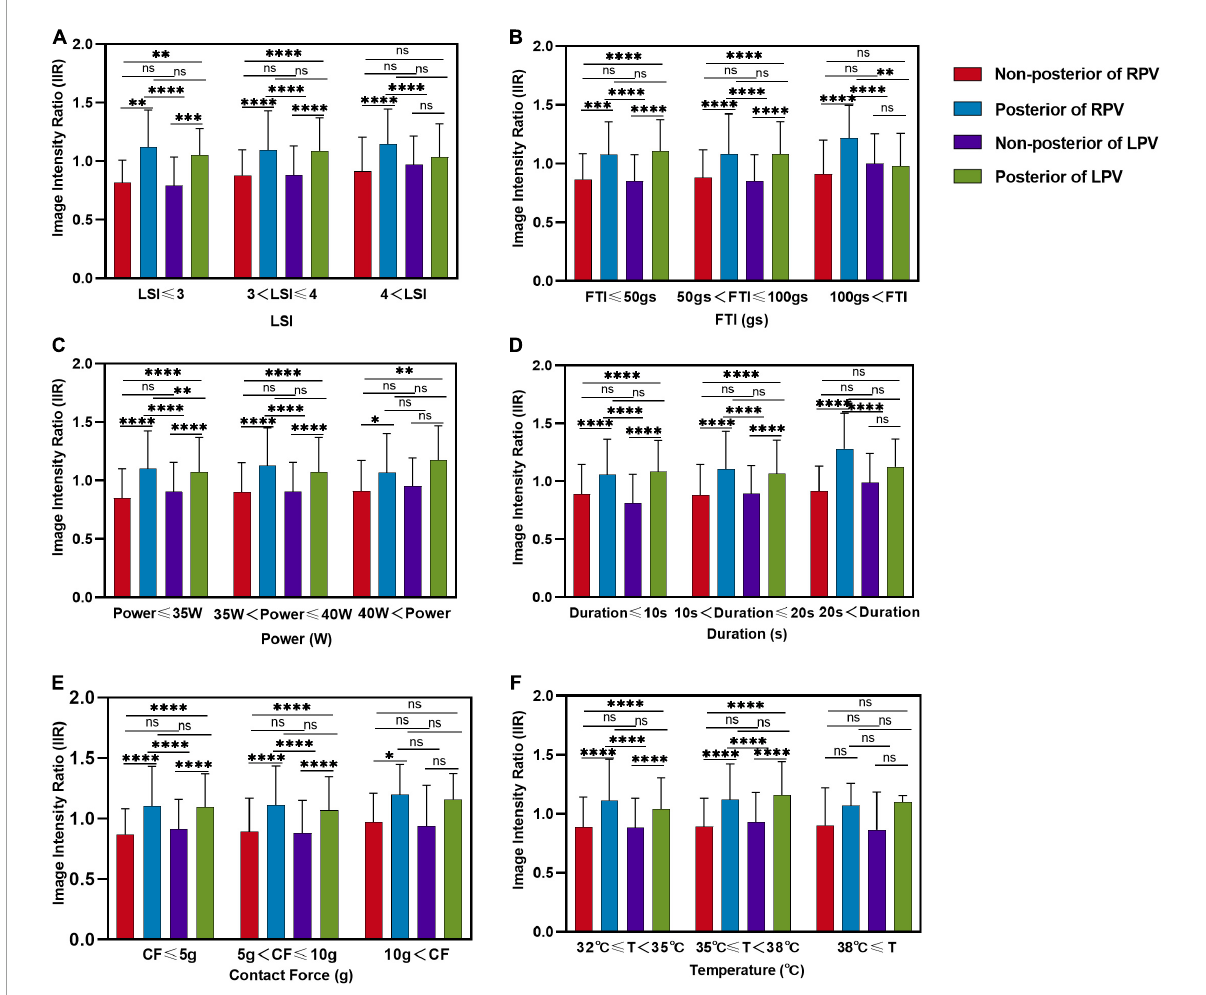
FIGURE5 Comparison of image intensity ratios between different locations of left atrium under different level ablation parameter categories. Comparison of the image intensity ratio between non-posterior of right PV, posterior of right PV, non-posterior of left PV and posterior of left PV with three levels of (A) LSI, (B) FTI, (C) power, (D) duration, (E) contact force, (F) temperature applications. LSI, lesion size index; FTI, force–time integral; CF, contact force; T, temperature; ns, non-significant. ∗ P < 0.05, ∗∗ P < 0.01, ∗∗∗ P < 0.001, and ∗∗∗∗ P <